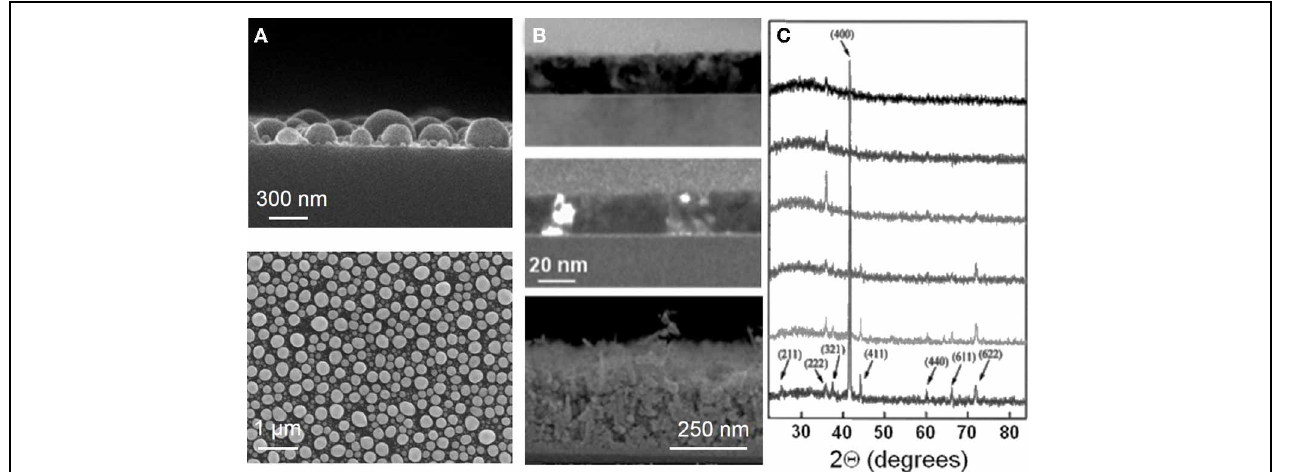
FIGURE 3 | SEM, TEM and XRD measurements of thin, porous ITO layers. (A) Cross-sectional and plan-view SEM images of ITO nanoparticles on silicon during initial MBE growth. (B) Bright field TEM image of a 25nm thick ITO layer formed after continued deposition beyond the stage shown in (A) . The corresponding dark field image underneath acquired